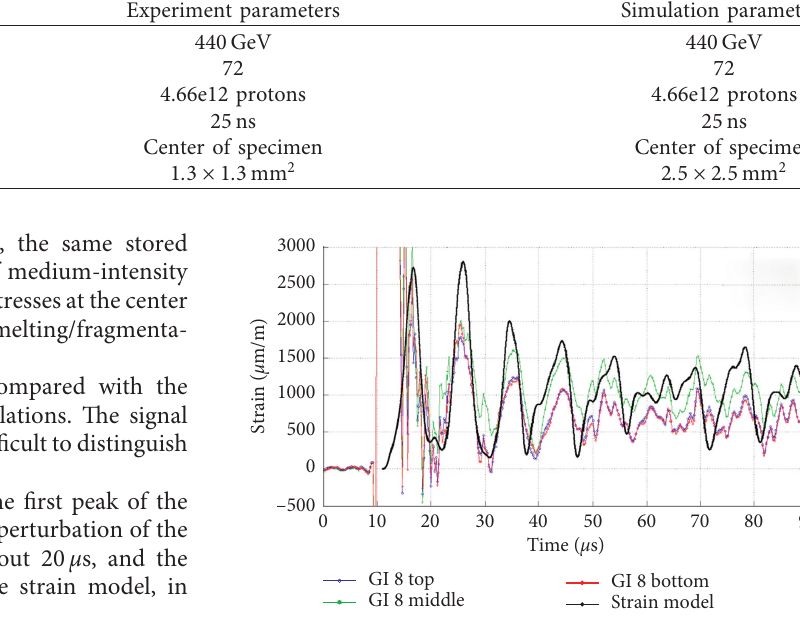
Figure 21: Results of the medium-intensity test on Glidcop ® , effect of the smoothing function on the hoop